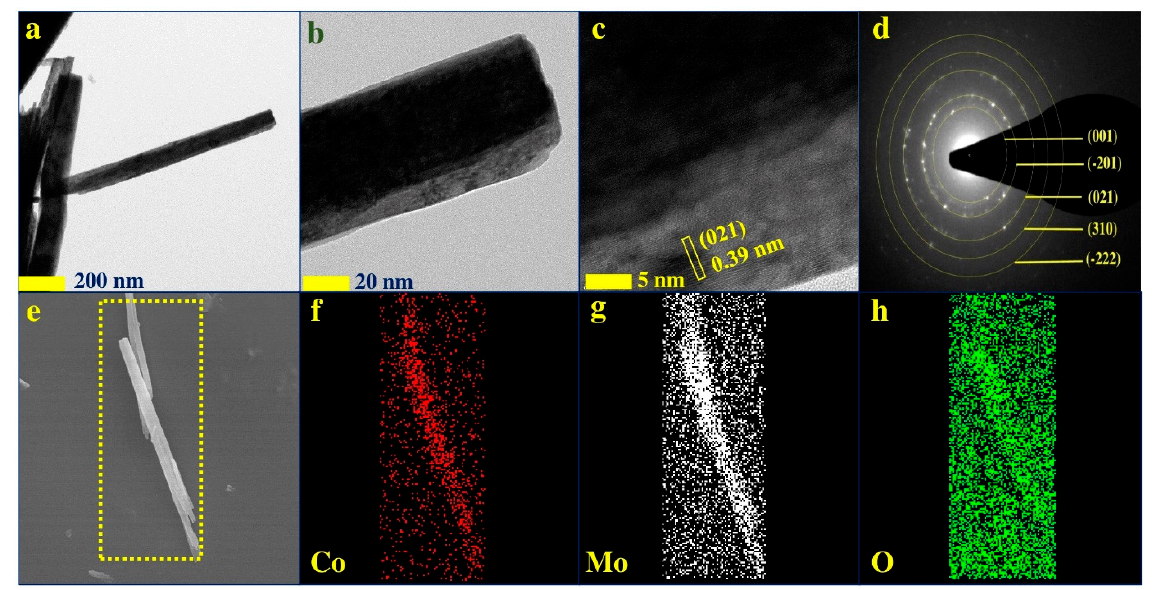
Figure 3. Low and high magnification TEM images ( a – c ), SAED pattern ( d ) of R-CMO and its corresponding elemental mapping ( e – h ).